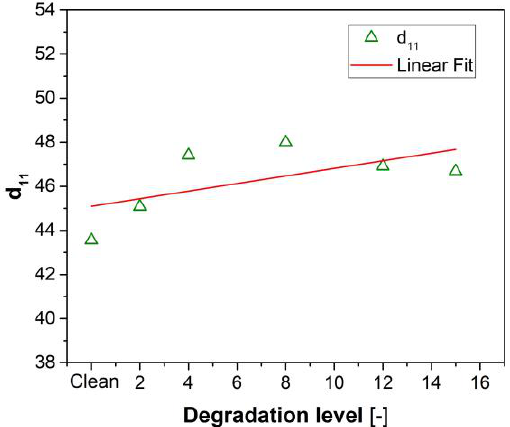
Figure 8. Coefficient d 11 of Matrix D computed from linearization for different levels of compressor degradation (dots) and the linear fit curve. Table 6. Matrices linear laws with degradation degree, h .